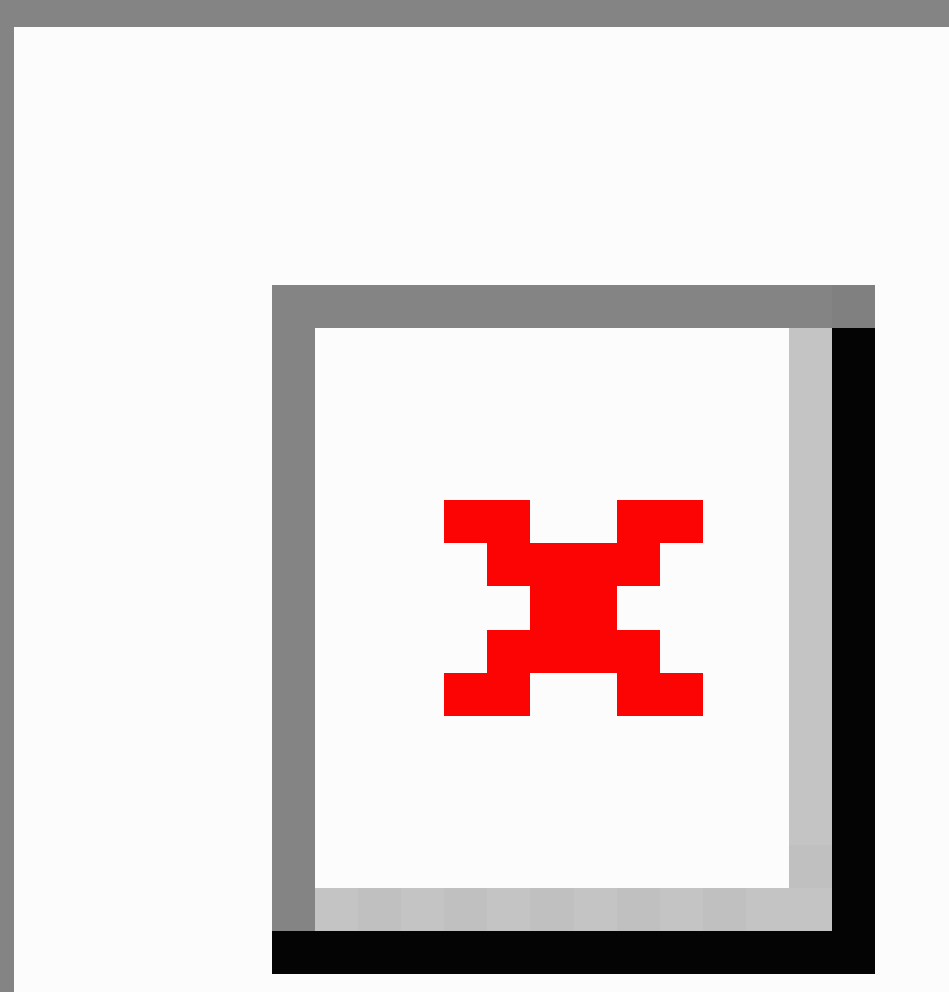
Figure 1. Examples of success and failure messages shown once step counts were